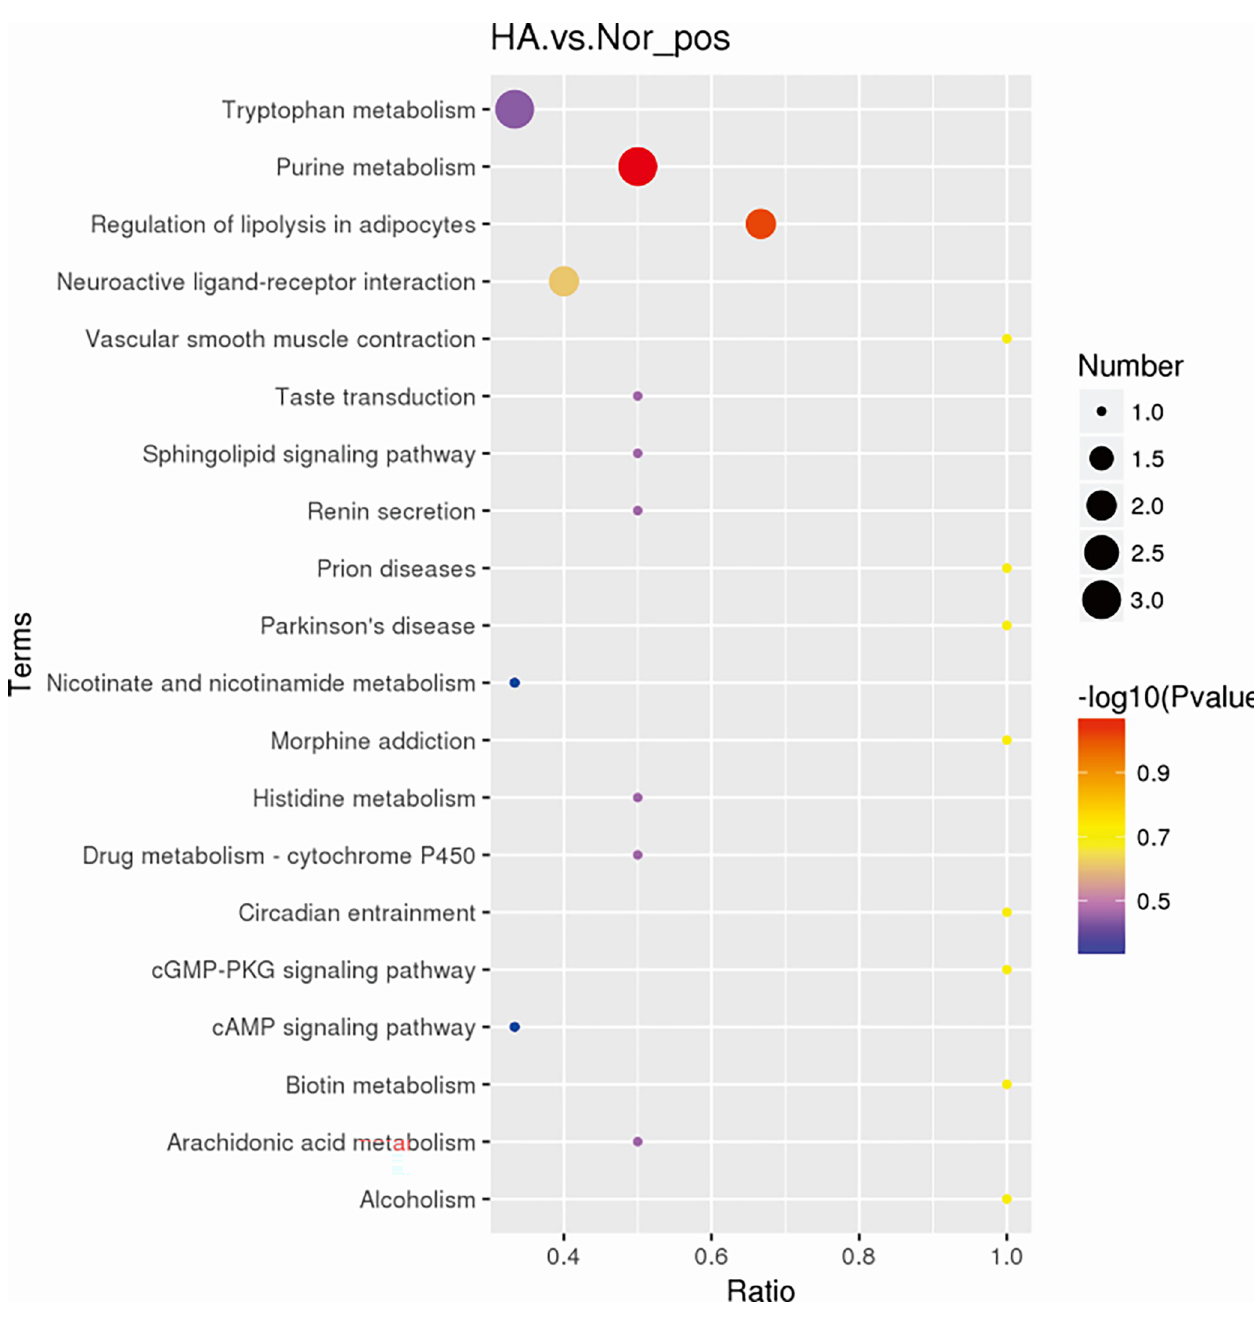
component analysis results indicated that the plasma metabolite profiles changed significantly